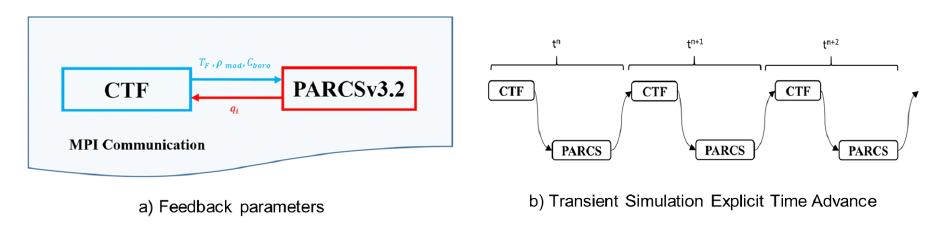
Figure 5. Coupled code information for ( a ) feedback parameters and ( a ) transient temporal